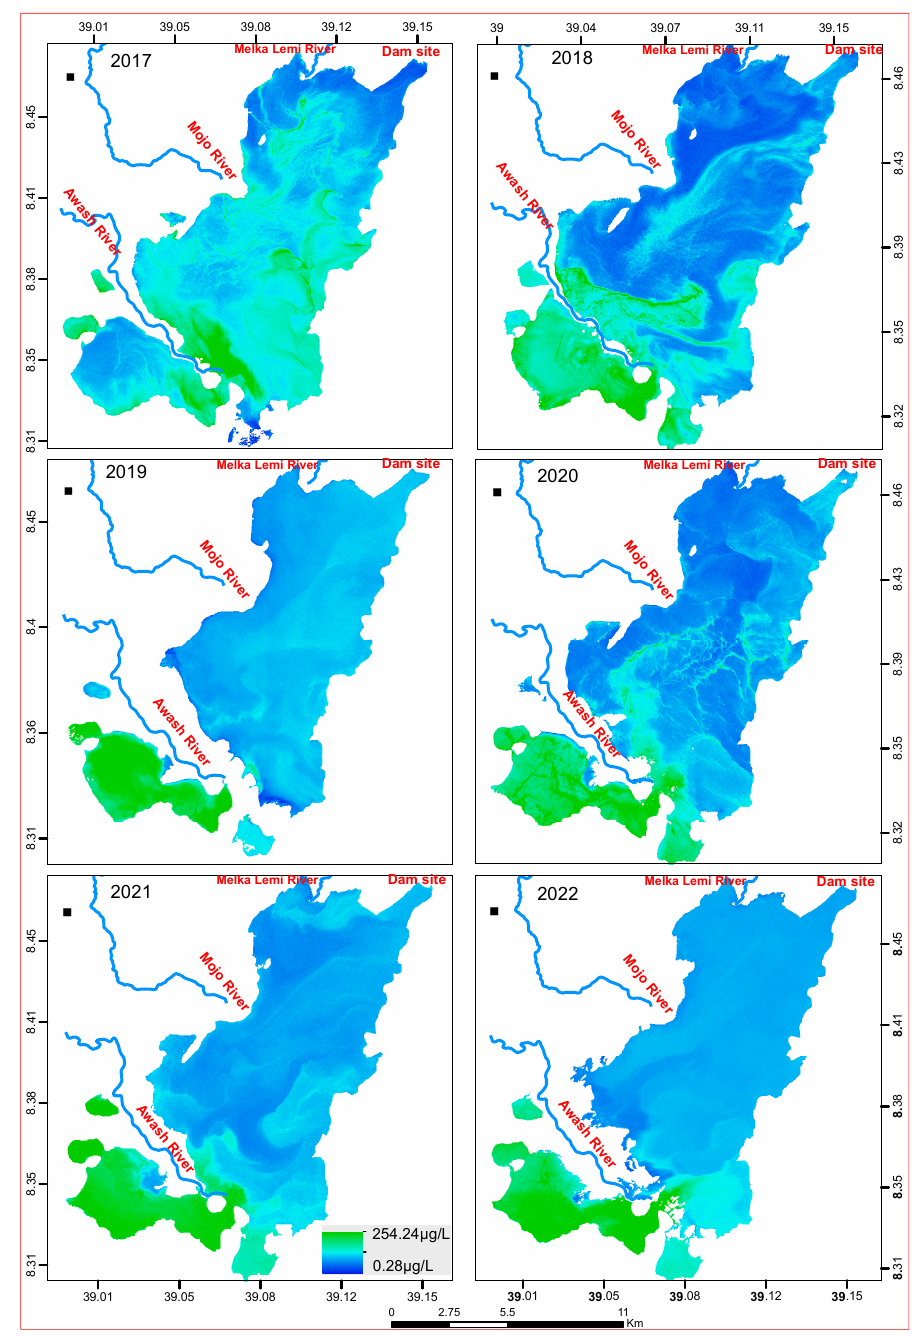
Figure 8. Annual distribution map of Chl-a (µg/L) from Sentinel-2 imagery using linear regression models.